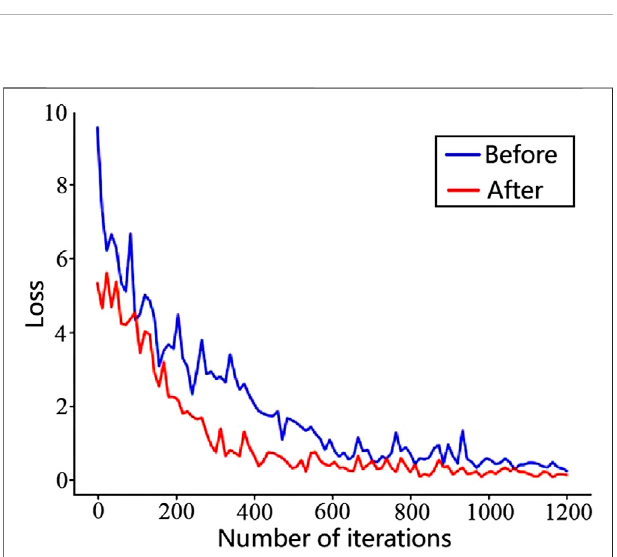
FIGURE 8 | Faster R-CNN ’ s loss function line graph before and after optimization for logical element